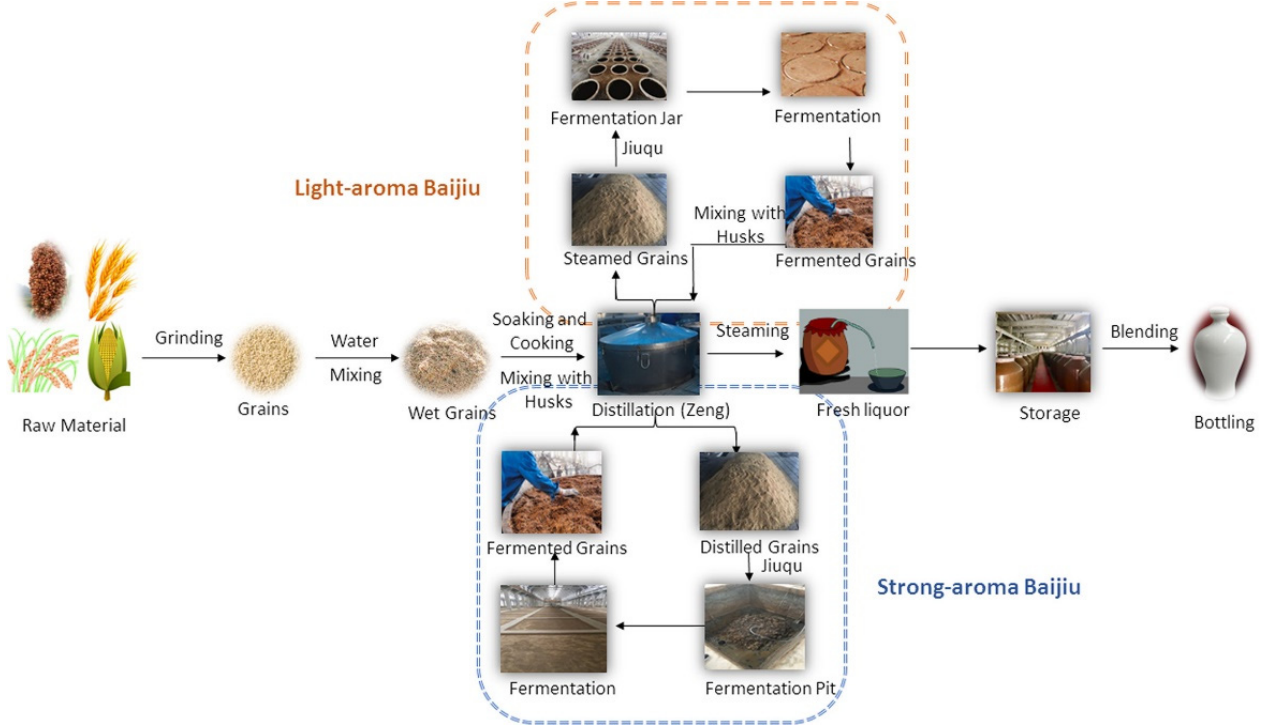
Figure 2. The traditional production processing of baijiu. Reprinted with permission from Ref. [1]. Copyright 2018, American Chemical